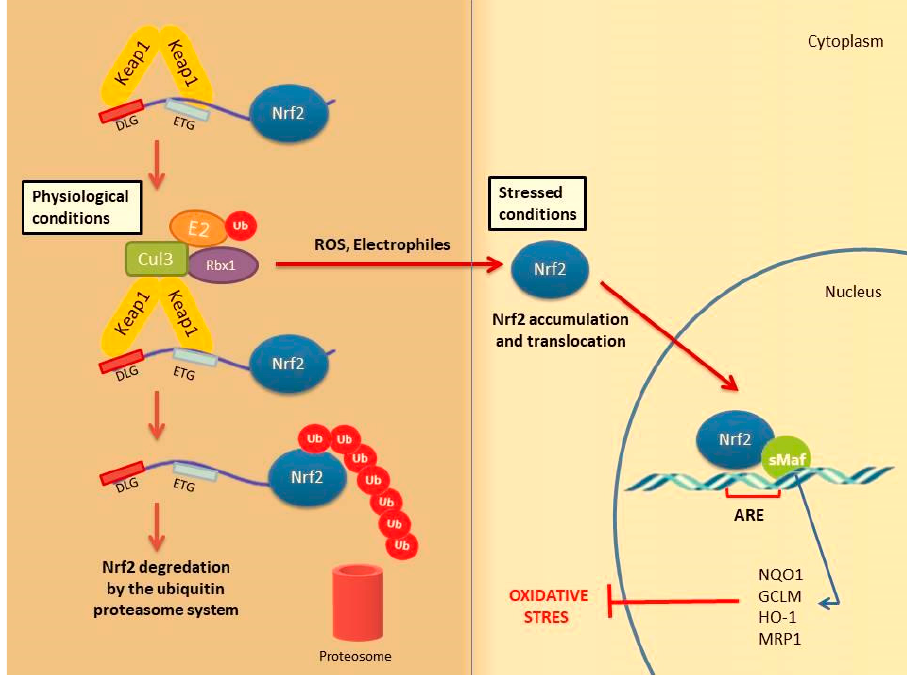
Figure 2. Nrf2 activation mechanism-canonical pathway. Under normal physiological conditions, Nrf2 forms a complex with the Keap1 protein Cul3 and Rbx, causing Nrf2 to be ubiquitinated and degraded by the ubiquitin proteasome system Under stress conditions, the Keap1 Cul3 complex is deactivated. This situation leads to the release and accumulation of Nrf2. Stable Nrf2 is translocated to the nucleus and binds to ARE together with small Maf proteins (sMaf). It ultimately activates antioxidant enzymes and cytoprotective proteins such as HO-1, NQO-1, GST. These enzymes support cellular defense by mediating the removal of ROS and cytotoxic electrophiles.